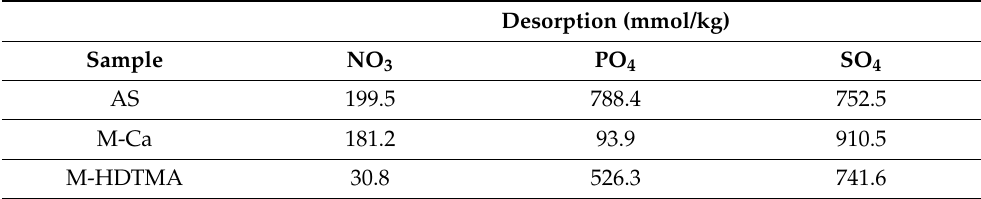
Table 7. Desorption results of NO 3 , PO 4 , and SO 4 from raw and modified samples.